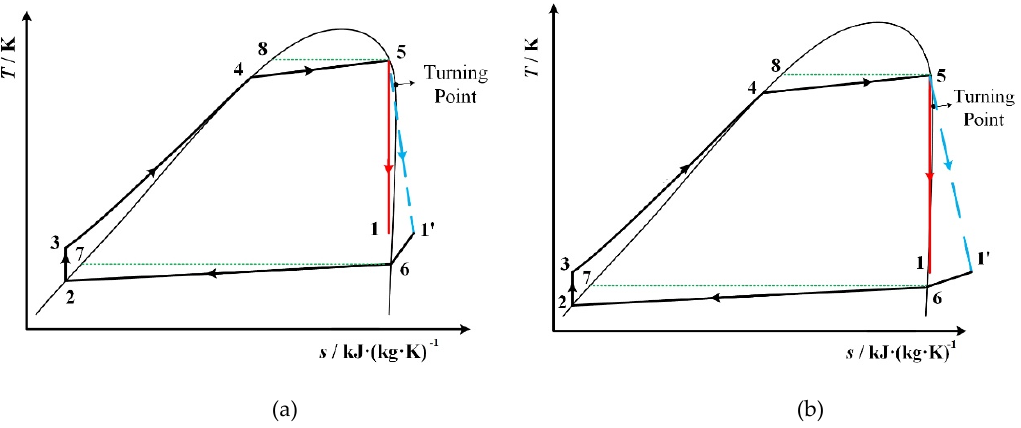
Figure 9. Subcritical ORC using single screw expander with isentropic zeotropic mixture as working fluid when considering isentropic efficiency of expander: (a) expander outlet at superheated region for R436A; (b) expander outlet at superheated region for R436B. Table 7. Description and determination of state points in Figure 8 and Figure 9.